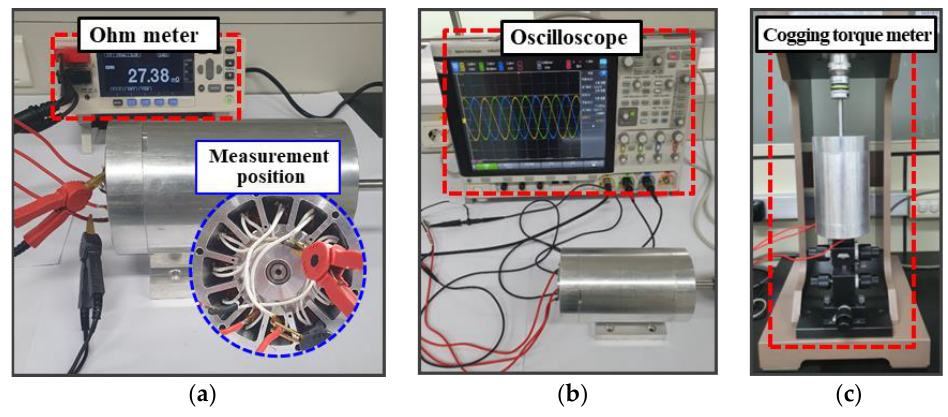
Figure 18. Testing: ( a ) Resistance, ( b ) back EMF, and ( c ) Cogging torque.